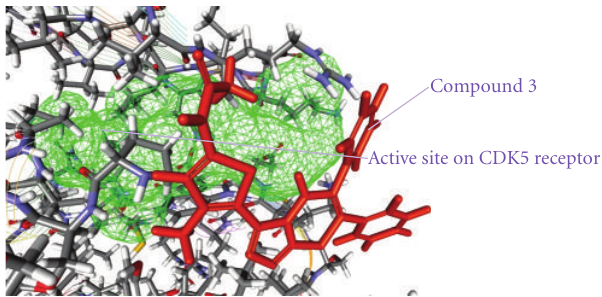
Figure 6: The docked conformation of compound 5 with the receptor CDK5/p25 (PDB: 3O0G). Compound 5 is indicated by red color while the most active site of the CDK5 receptor is shown with purple color.